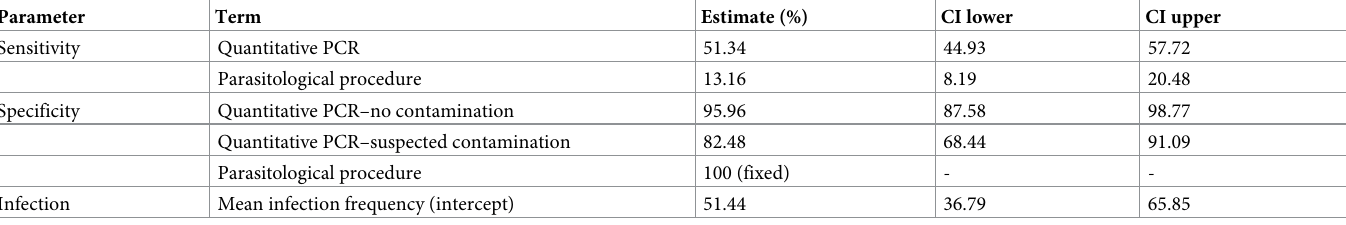
Table 9. Effects of dog clinical status on the sensitivity of Leishmania diagnostic procedures: Estimates from the top-ranking model in the third round of analyses (model {32}). Parameter